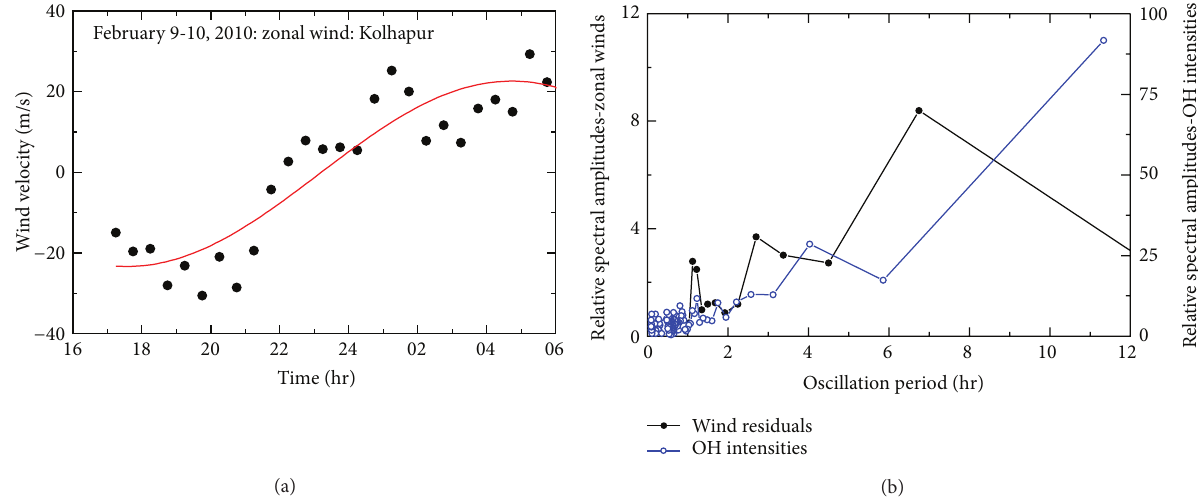
Figure 5: The averaged zonal wind variability during 1800 h to 0600 h on February 9-10, 2010 for 86–92 km altitudes (a). The Fourier analysis of zonal residual winds and OH intensity data shown in the bottom (b) indicate commonality in the period of oscillation in both data.